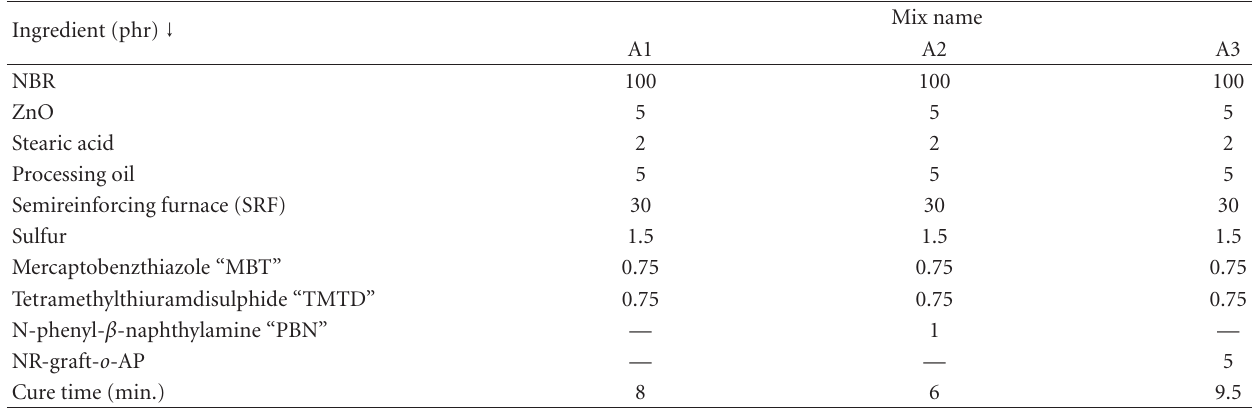
Table 1: Formulation of NBR vulcanizates containing PBN, NR-g- o -AP, and control